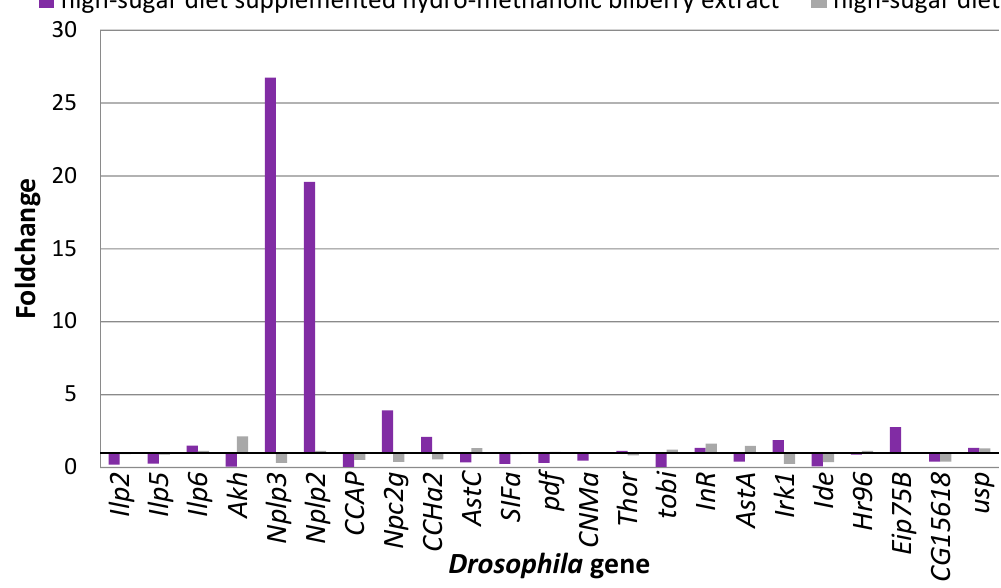
12 of 33 Figure 4. Foldchange in neuropeptide gene expression of wild-type Drosophila melanogaster reared for 12 days on a high-sugar diet, as compared to a normal diet control. Data reported as average of triplicate experiments, as ratio of gene expression values on high-sugar diet to gene expression levels on normal diet control. Upon high-sugar diet supplementation with 3% hydro-methanolic bilberry extract (E3), the foldchanges in mRNA expression of the analyzed neuropeptide-encoding genes were more dramatic